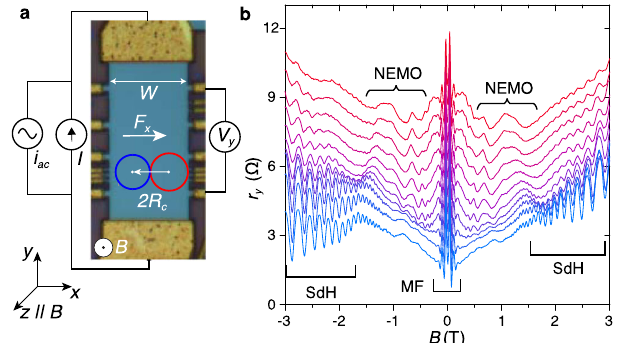
Fig. 1 Current dependence of magnetoresistance oscillations in monolayer graphene Hall bars. a Optical micrograph image of the graphene Hall bar ( W = 15 μ m) and a schematic diagram of the measurement con fi guration. b Plots of differential resistance r y = d V y /d I at T = 5 K as a function of B for DC currents, I , between 0 (blue) and 140 μ A (red) in 14 μ A intervals, curves are offset by 0.7 Ω for clarity. Curly brackets indicate the emergence of additional non-equilibrium magneto-oscillations (NEMOs) examined in detail in Figs. 2 and 3. Square brackets labelled SdH indicate Shubnikov – de Haas oscillations and square brackets labelled MF indicate the magnetic focussing